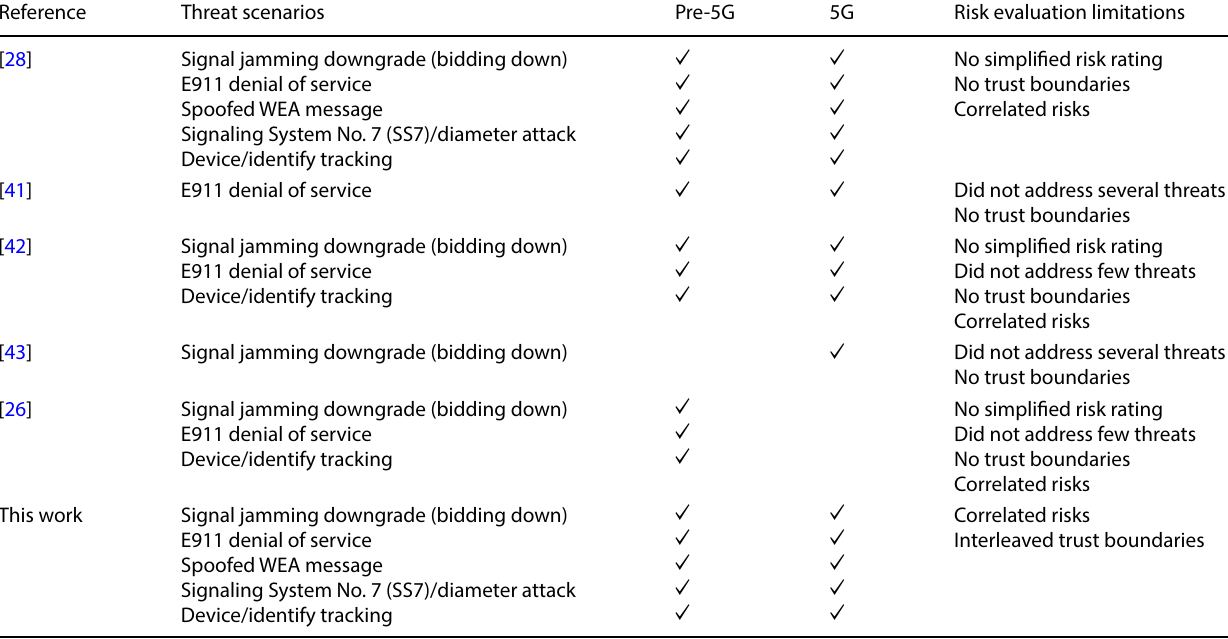
Table 12 Comparison with existing risk evaluation methods